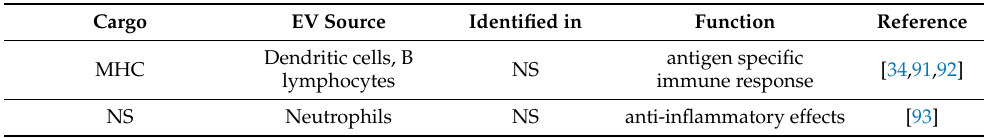
Table 3. Table summarizing studies with a role for EVs in mediating inflammation sepsis and lung disorders. NS—not specified in the original